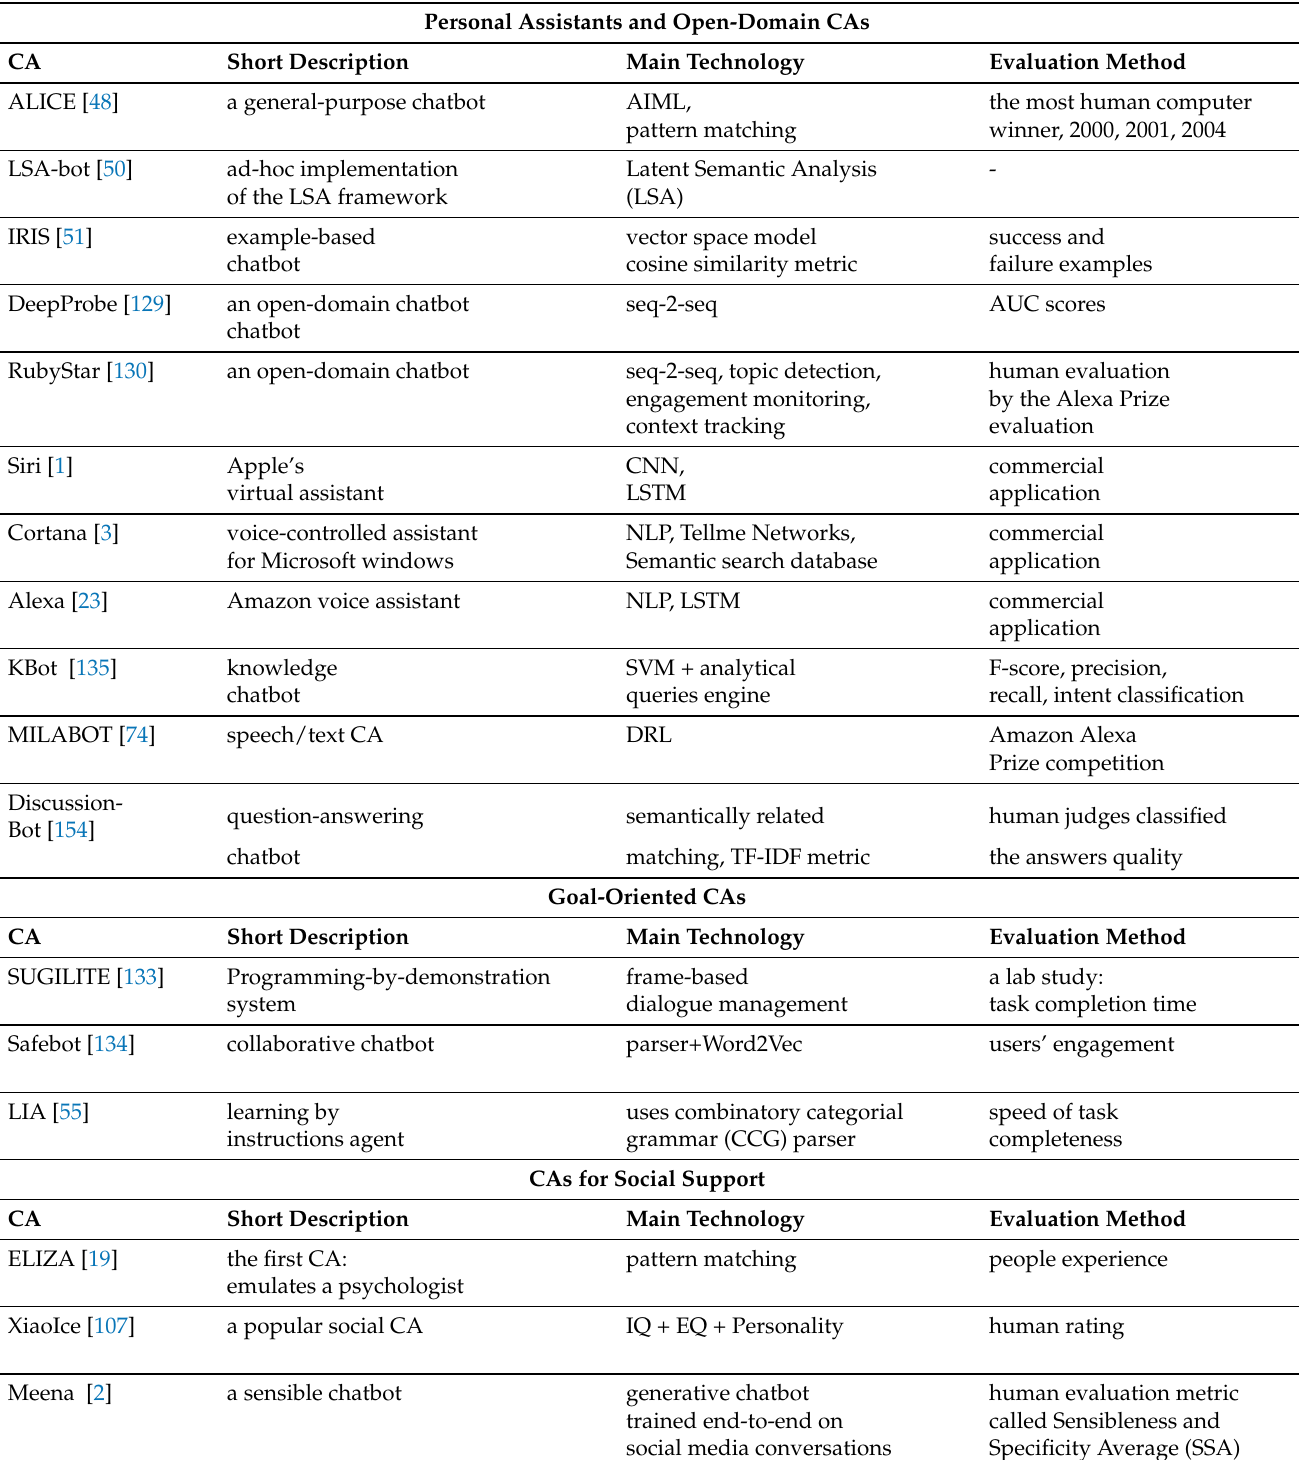
Table 1. Technologies and evaluation methods for main CA applications: Part